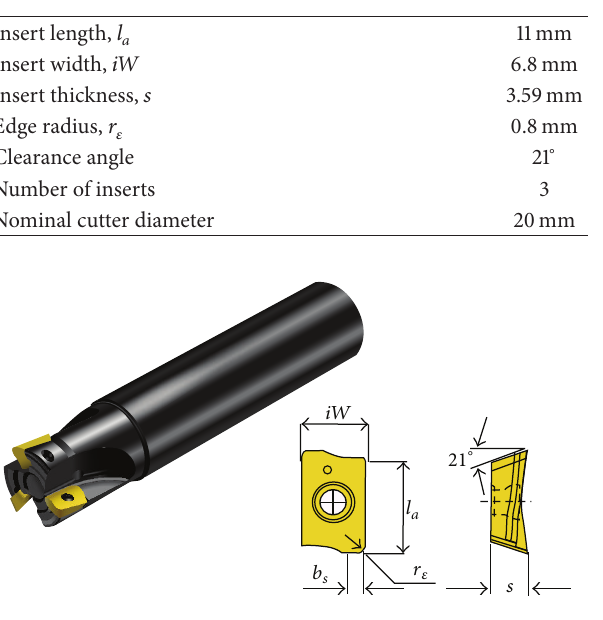
Figure 2: End mill and insert used in the cutting